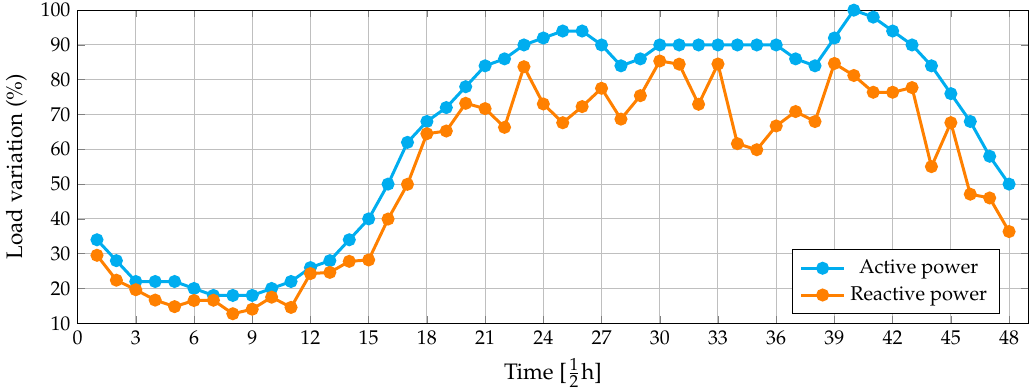
Figure 2. Typical behavior of the active and reactive power consumption in Colombia